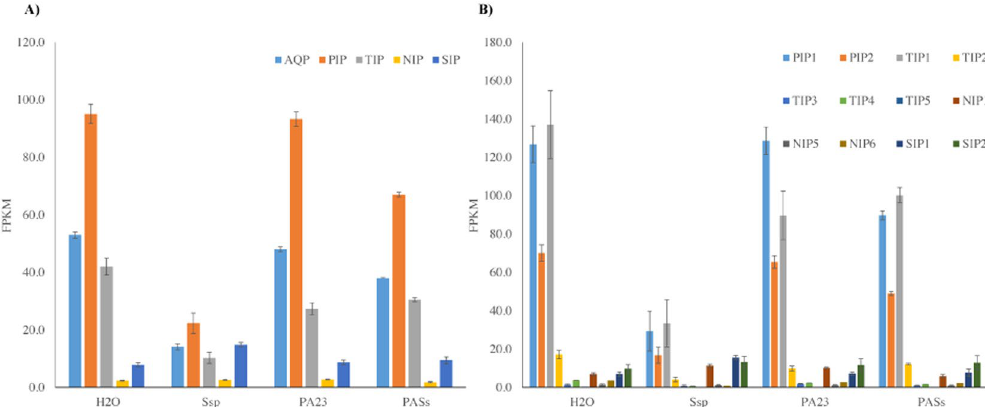
Figure 8. Expression of Brassica napus AQP in mature leaf inoculated with Sclerotinia sclerotiorum (Ssp), biocontrol agent Pseudomonas chlororaphis (PA23) and combined both together retrieved from Bioproject PRJNA331148. Graphs are showing expression level in term of average reads per kilobases of transcript per million mapped reads (RPKM) for ( A ) four AQP subfamilies namely PIP, Plasma membrane intrinsic protein; TIP, Tonoplast intrinsic protein; NIP, Noduline-26 like intrinsic protein; SIP, Small intrinsic protein; and ( B ) groups in each subfamily. Bars represent standard error from the mean for all values within a subfamily or a group out of three biological replicates. Detailed data are provided in Supplementary Dataset 4.